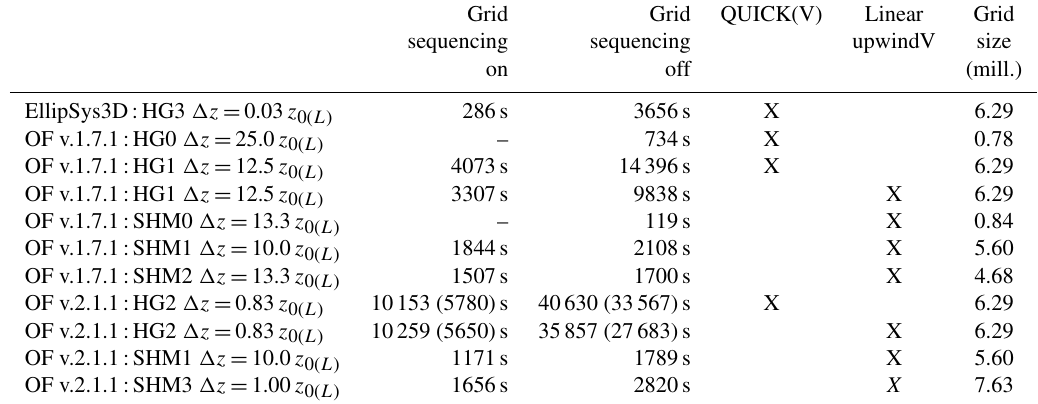
Table 6. Bolund Hill: simulation times for EllipSys3D and OpenFOAM codes. For information about different grids utilized in the com- putations, see Table 5 and Fig. 8. The OpenFOAM v.2.2.1 runs on the HG2 grid are conducted using the PCG pressure solver (results in parentheses) instead of GAMG